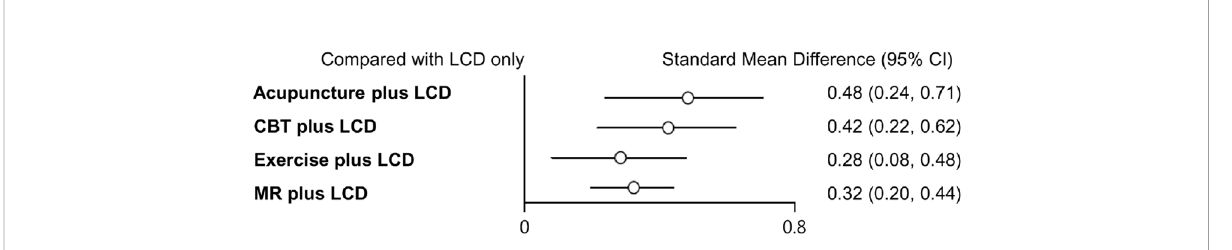
FIGURE 4 Forest plots of each intervention compared with LCD alone. LCD, low-calorie diet; CBT, cognitive behavioral therapy; MR, meal